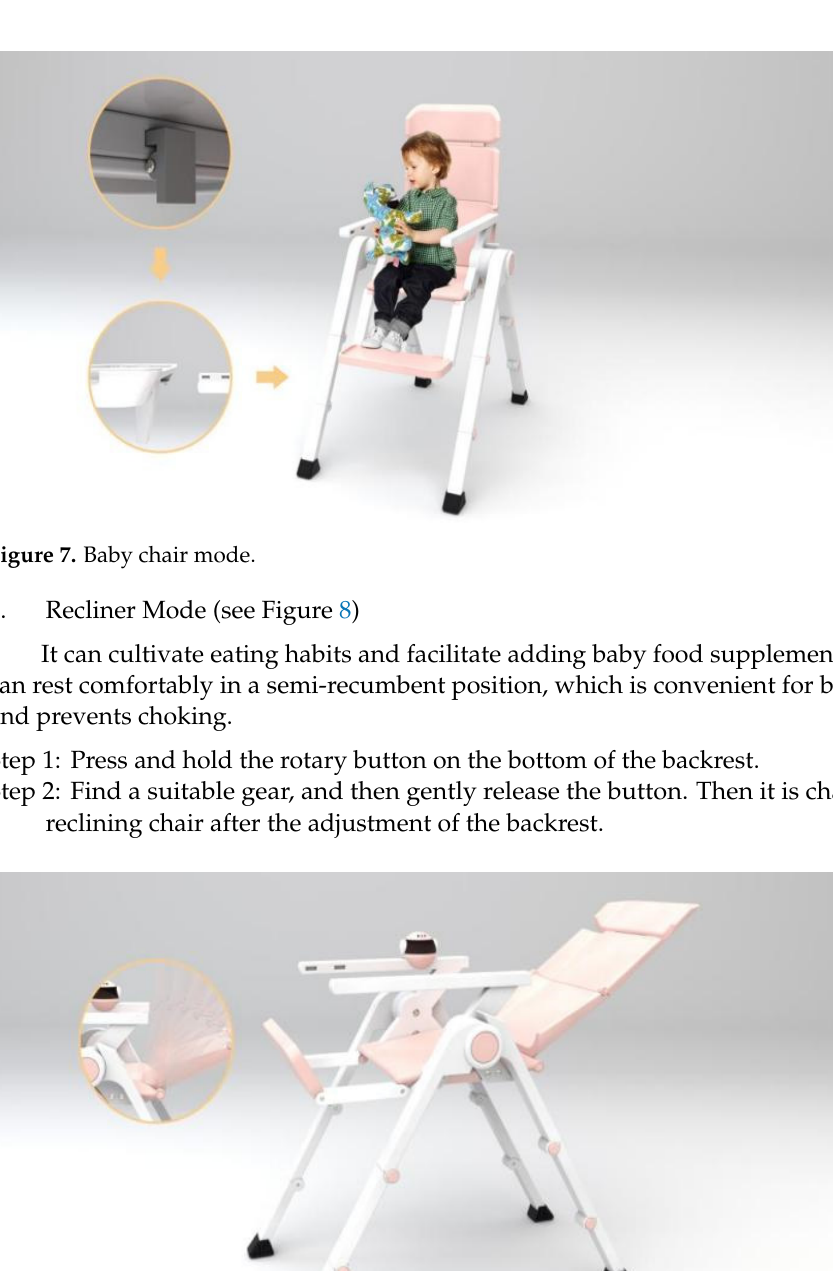
Figure 9. Storage mode. 3. Neural Approximation-Enhanced Cartesian Impedance Control Compared with manual adjustment of the position of the backrest and the footrest of the baby chair, a robotic implementation of this functionality provides more accuracy, smoothness and flexibility. Therefore, for a better consumer experience, in this section, we focused on the robotic control of the chair posture adjustment. We first modelled the struc- ture of the baby chair and subsequently implemented a Cartesian impedance control with neural approximation to compensate for the environmental uncertainties. 3.1. Baby Chair Structure Modeling The two joints of the baby chair that can be controlled are shown in Figure 10. Con- sidering its mechanical design, we modelled the chair as a 2-degrees-of-freedom (dof) structure with three links connected by two motorized joints, as illustrated in Figure 11.